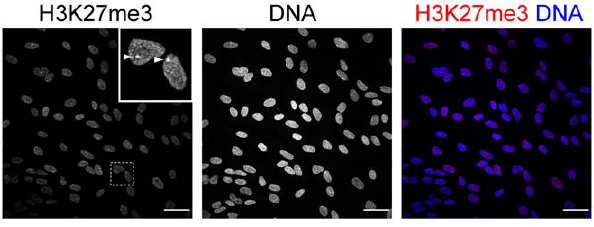
Figure 4. H3K27me3 staining of endometrial stromal cells. Accumulation of H3K27me3 on X-chromosomes was observed in . 90% of the cells. Scale bars are 50 m m.